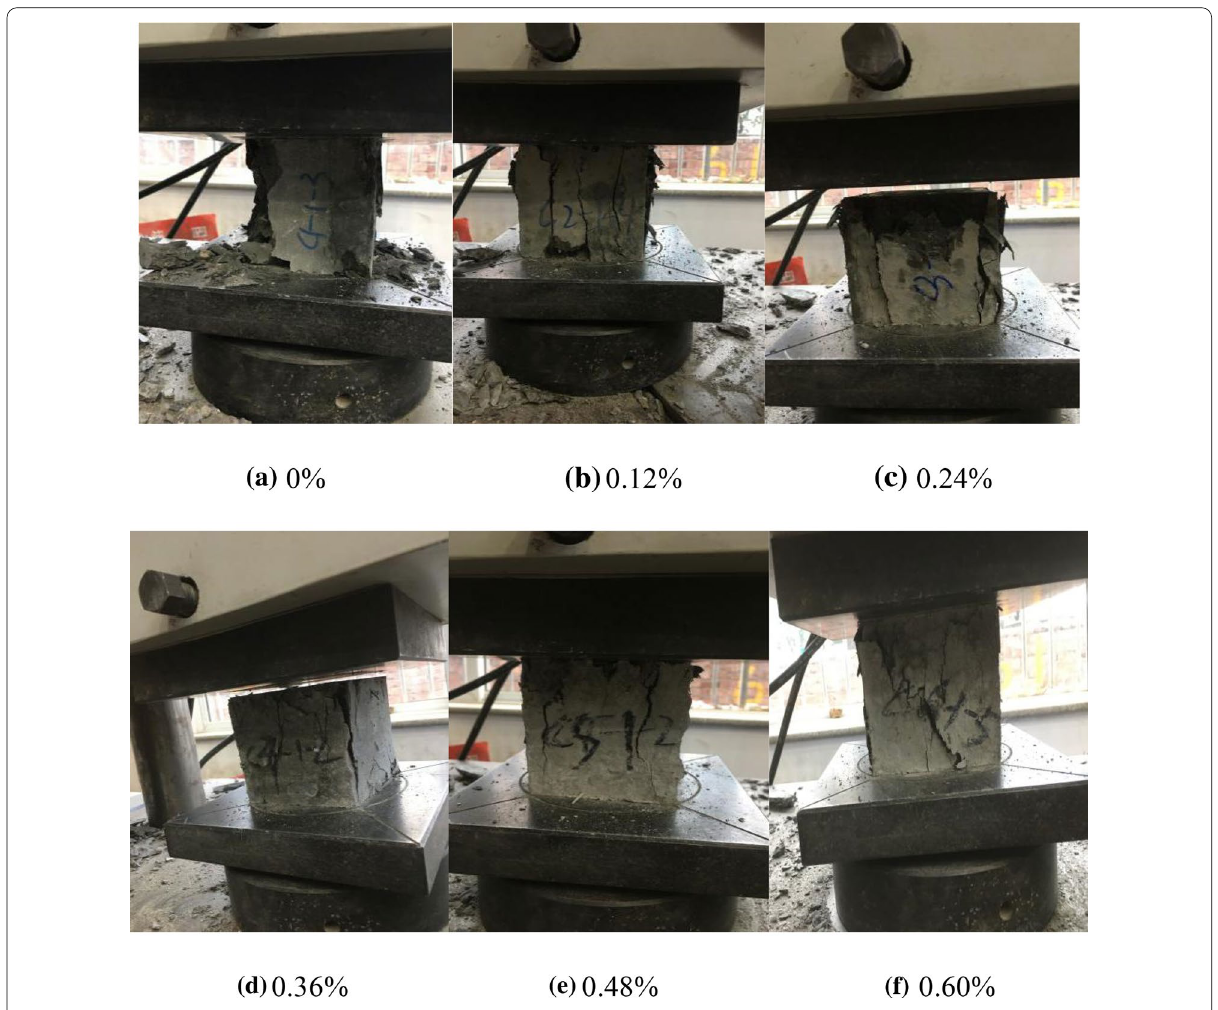
Fig.4 HFRC failure modes with different fraction volume. a 0%. b 0.12%. c 0.24%. d 0.36%. e 0.48%. f